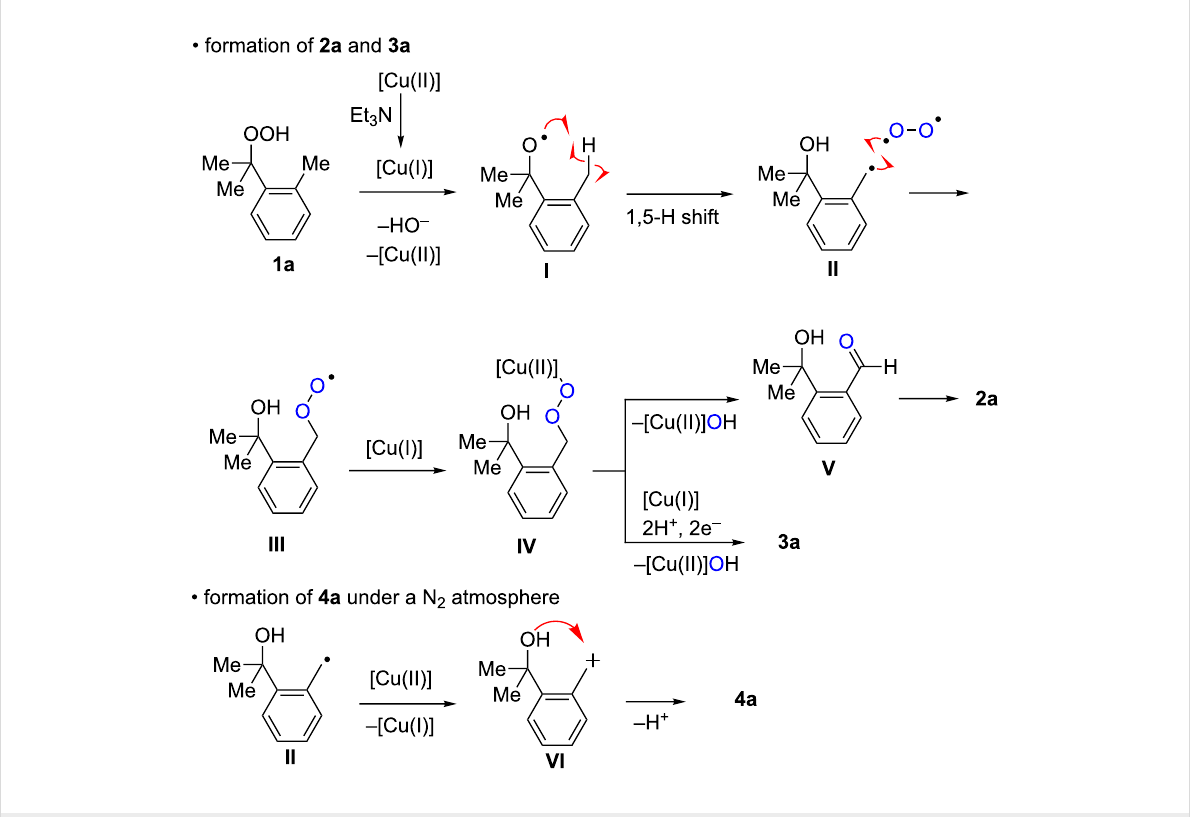
Scheme 3: Proposed reaction mechanisms for the formation of 2a , 3a , and 4a